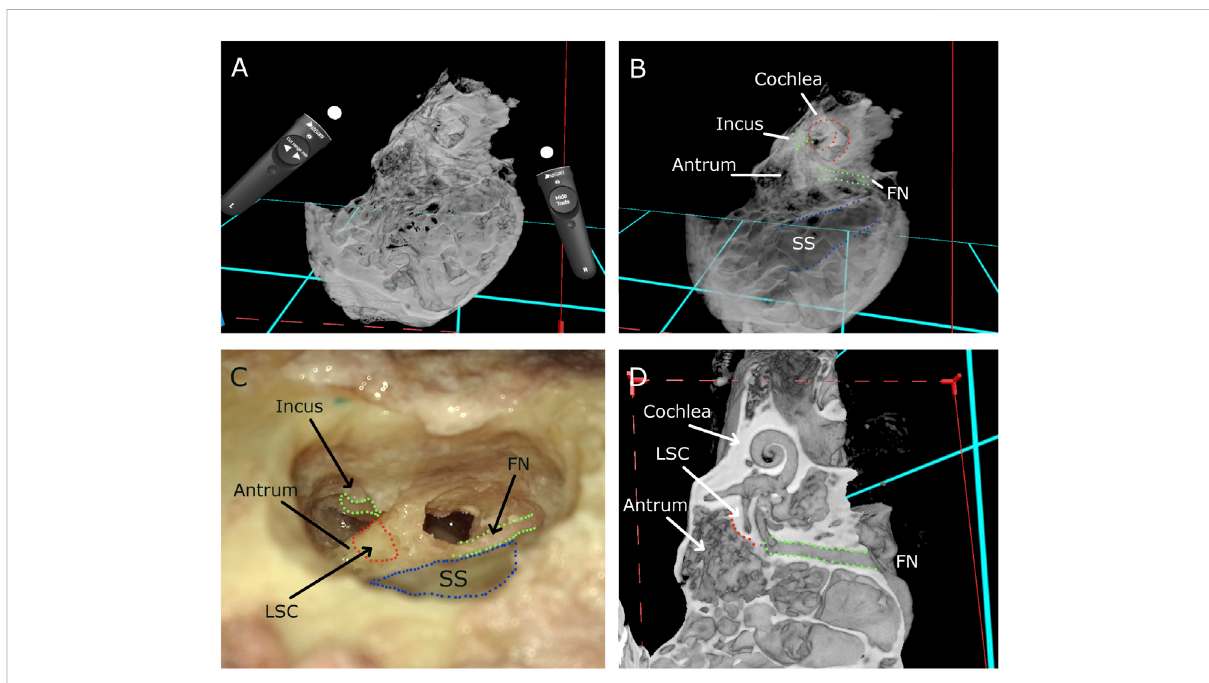
FIGURE 4 (A) Temporal bone and a pair of controllers in VR environment, (B) temporal bone with translucent image windowing, (C) dissected cadaveric temporal bone, and (D) temporal bone and surgical landmarks in VR environment. FN = facial nerve, LSC = lateral semicircular canal, and SS = sigmoid